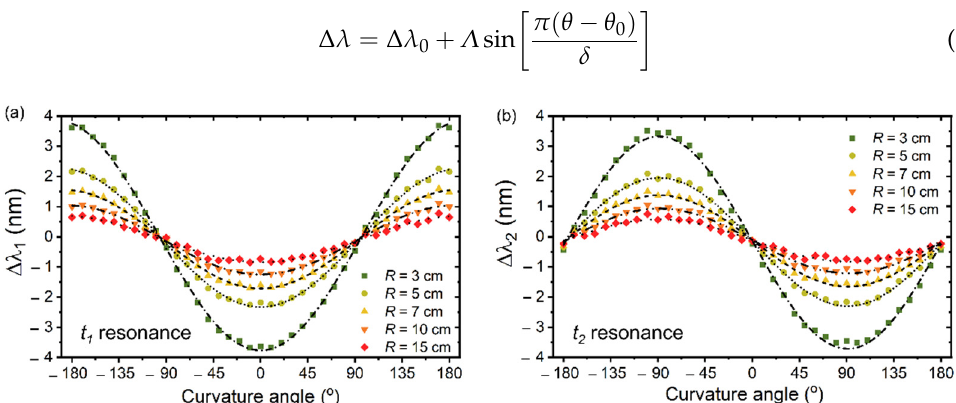
Figure 4. Wavelength shifts as a function of the curvature angle ( θ ) for different curvature radii ( R ) for the resonances associated with the tubes with thicknesses ( a ) t 1 ( Δ λ 1 ) and ( b ) t 2 ( Δ λ 2 ).